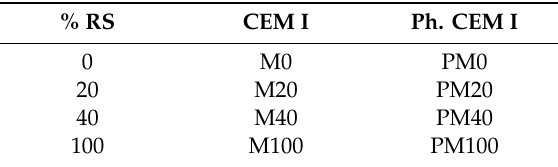
Table 2. Nomenclature of mortar